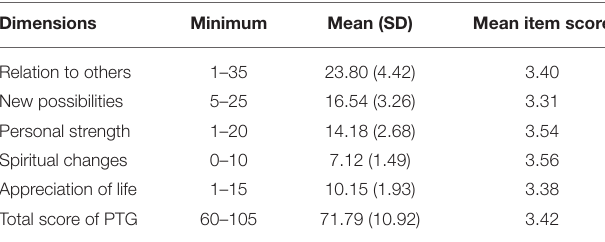
TABLE 1 | Post-traumatic growth scores and dimensions in the adolescents who experienced PTG ( N = 80,025).